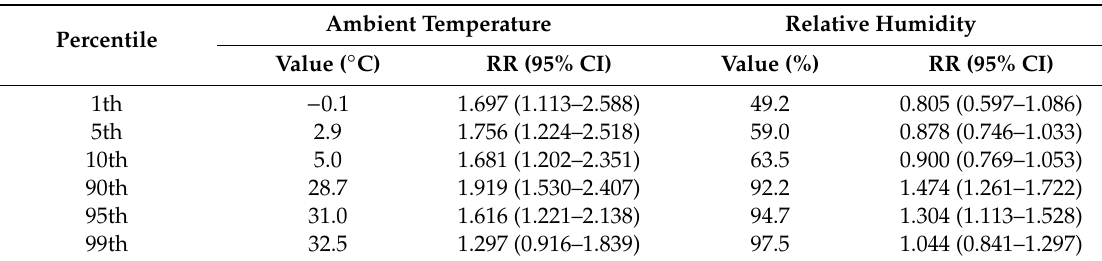
Table 3. The cumulative e ff ects of extreme meteorological factors on the incidence of HFMD at lag0–14. Ambient Temperature Relative Humidity Percentile Value ( ◦ C) RR (95% CI) Value (%)